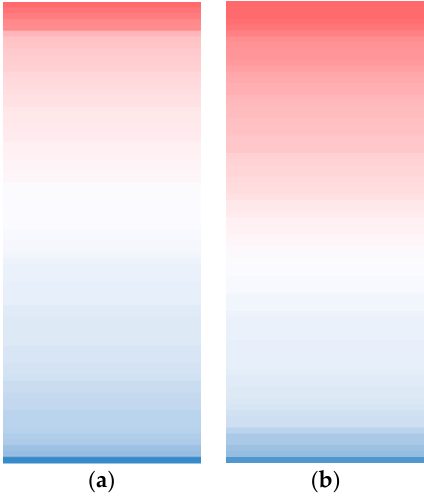
Figure 6. Selectivity profile of active compounds in a panel of 79 kinases. The inhibitory effect was examined at inhibitor’s concentration of 0.1 µM by determination of residual kinase activity. The data are presented as a heatmap. The columns have been individually ranked from low (red) to high (blue) residual activity values. The raw data are shown in the Supplementary Table S1. ( a ) Selectivity profile of 1 ; ( b ) Selectivity profile of 3 (MRC, Dundee, Scotland).